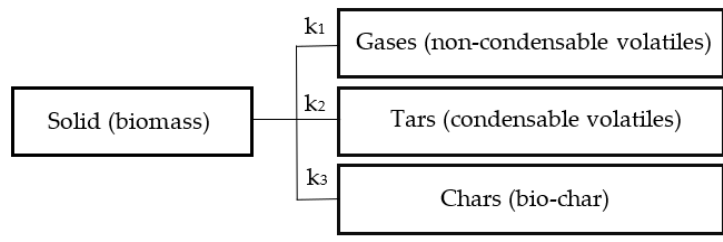
Figure 2. The competitive model with three reactions in the reaction